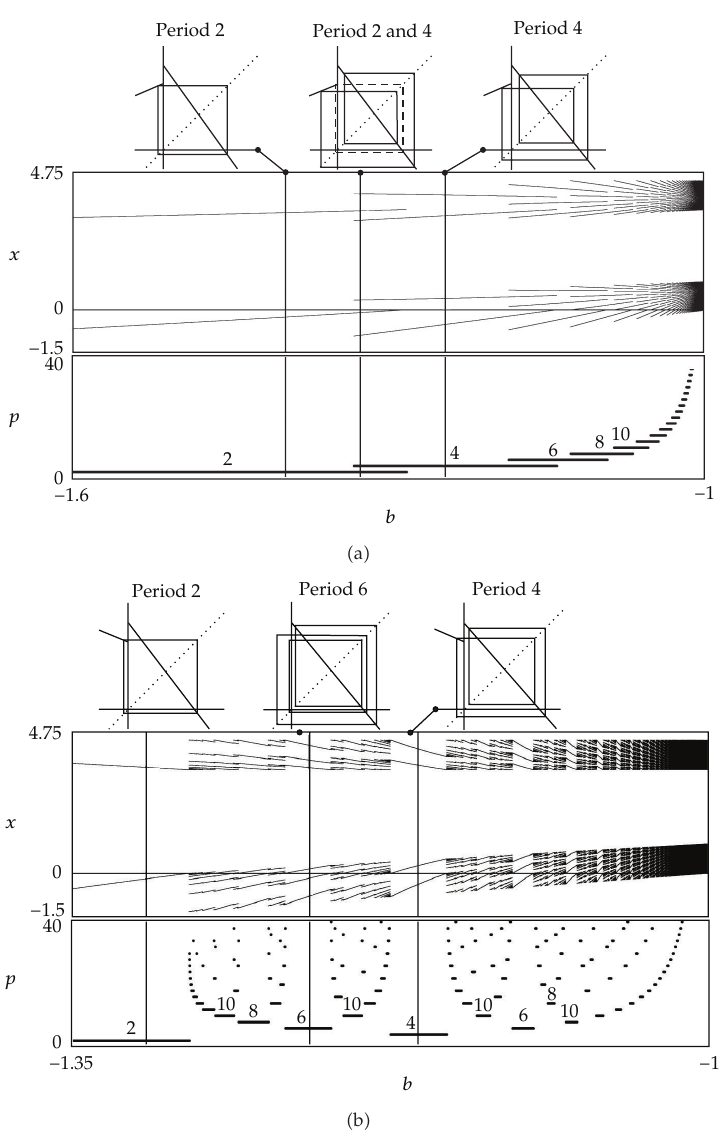
Figure 1: The period increment scenario with coexisting attractors (cid:7) a (cid:8) and the period adding scenario (cid:7) b (cid:8) in map (cid:7) 1.3 (cid:8) . For each scenario three sketches of the map, a bifurcation diagram and a period diagram are shown. Parameter values are: a (cid:6) 0 . 42, μ (cid:6) 3 . 5 (cid:7) a (cid:8) and a (cid:6) − 0 . 42, μ (cid:6) 3 . 5 (cid:7) b (cid:8) . Their locations are shown in Figure 2 with gray lines marked with “ D ” and “ E